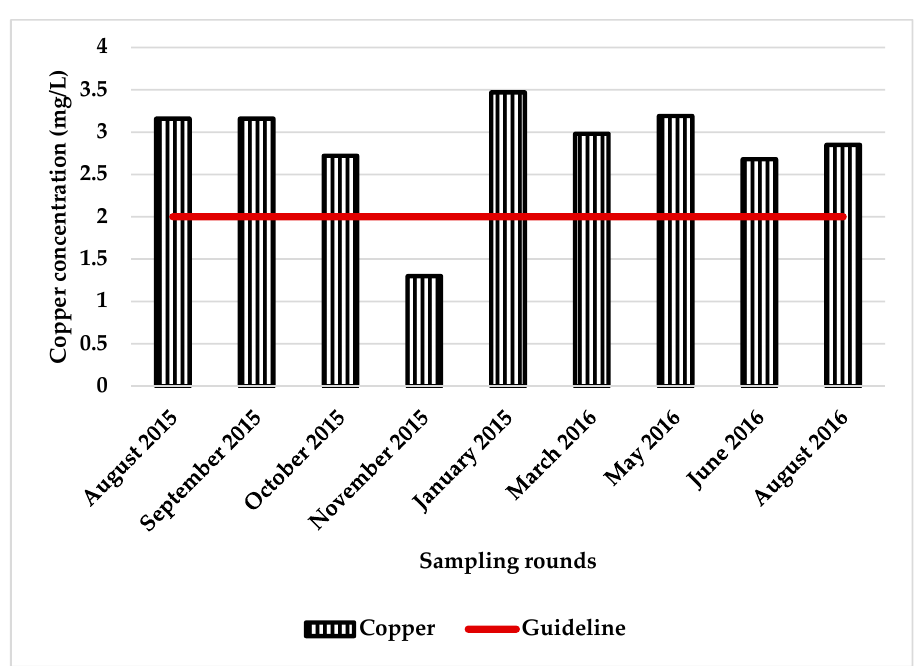
Figure 5. Levels of copper in the one tank found to have cooper above the ADWG.